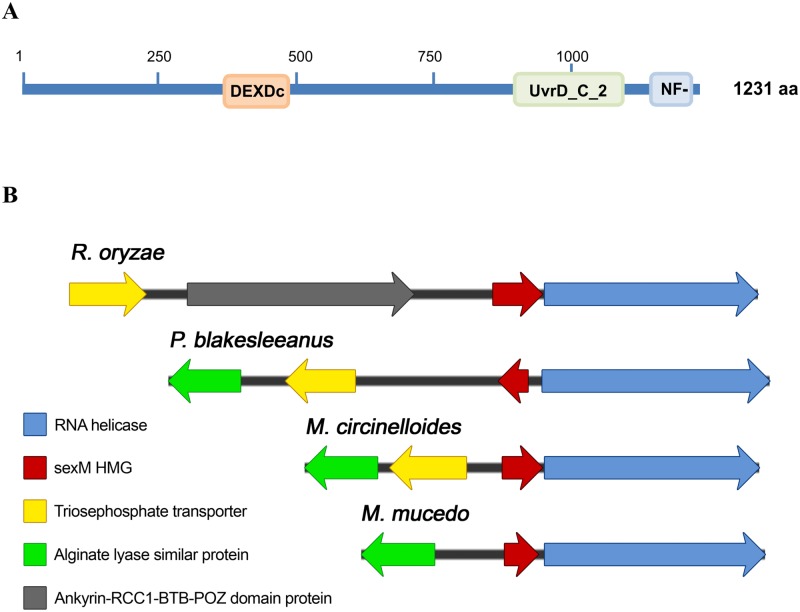
M. circinelloides RnhA protein (RNA helicase).(A) Structure of the putative M. circinelloides RnhA helicase. Three conserved domains can be found by blast with the NCBI database (http://www.ncbi.nlm.nih.gov/Structure/cdd/wrpsb.cgi): DEXDc domain, UvrD_C_2 domain, and a NF-X1-zinc-finger domain. (B) Conserved putative helicases are found in related fungal species close to the sex locus. Four different related fungal species are depicted: Rhizopus oryzae, Phycomyces blakesleeanus, Mucor circinelloides, and Mucor mucedo.